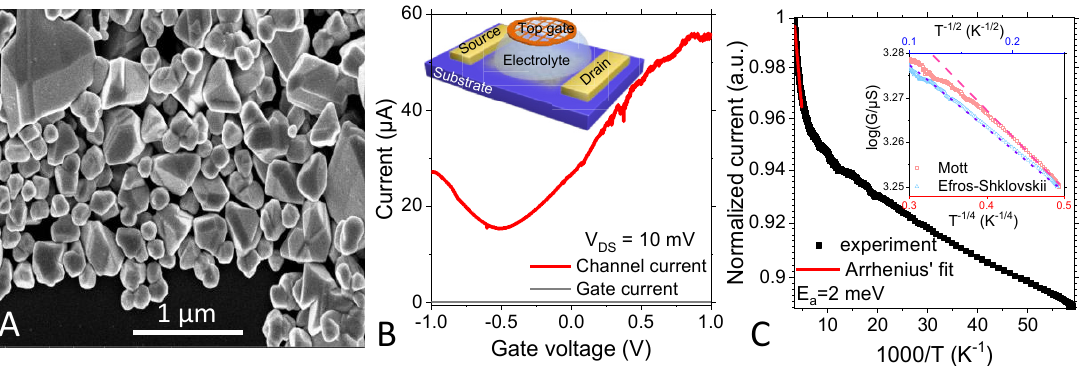
Figure1: (A)ScanningelectronmicroscopyimageoflargeHgTeNCs.(B)Transfercurve(drainandgatecurrentasafunctionoftheappliedgate bias) for a thin film madeof large HgTe NCs used as the channel of an electrolytic transistor. Inset is a schemeof the field-effect transistor. (C) Current in logarithmic scale as a function of the temperature for a thin film made of large HgTe NCs. Arrhenius ’ fit of the curve in the vicinity of room temperature leads to an activation energy of 2 meV. The inset is a plot of the log of the current as a function of T − 1/2 and T − 1/4